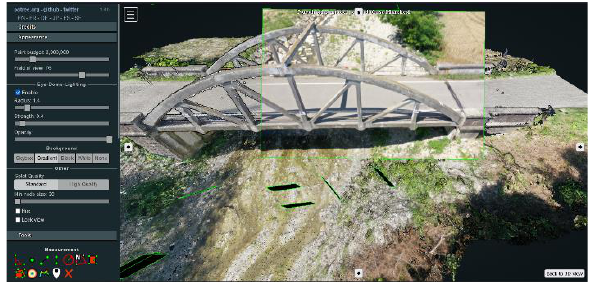
Figure 2. Example of a web-based interactive platform for exploring 3D products with oriented images developed with Potree